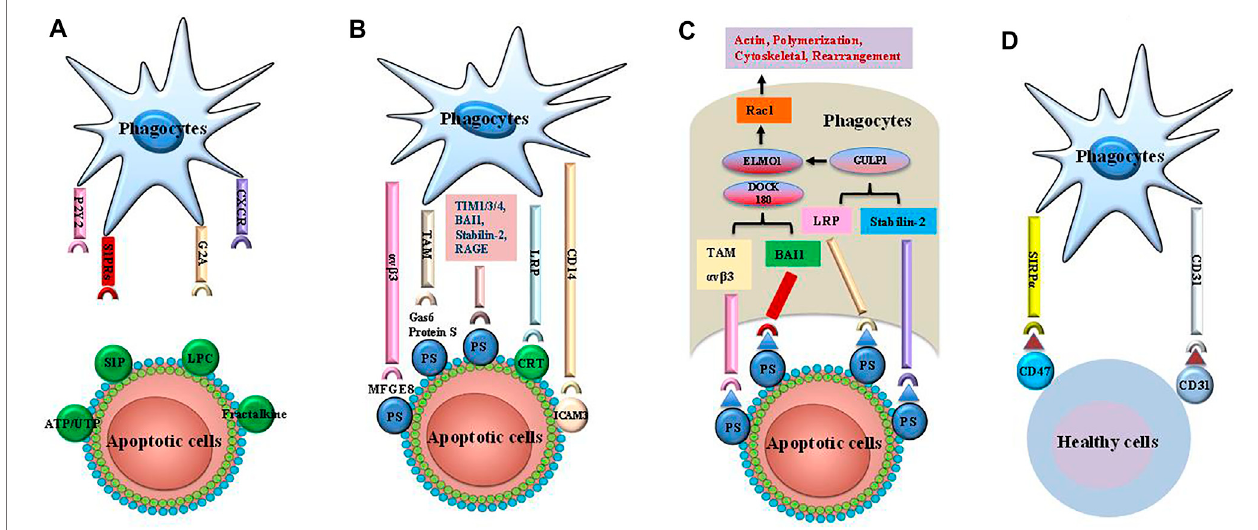
FIGURE1| Thestepsofefferocytosis.Efferocytosisisamulti-stepsprocessthatinvolvesseveralsteps: fi ndingapoptoticcells,bindingapoptoticcells,internalizing and digestion of apoptotic cells. (A) The apoptotic cells release a series of “ fi nd me ” signals including lysophosphatidylcholine sphingosine-1-phosphate (S1P), uridine diphosphate (UTP) and adenosine triphosphate (ATP), which attract phagocytes to region of apoptotic corpses. These signals are recognized by phagocytes using cognate receptors such as CXCR3, G-protein-coupled receptor (G2A), purinergic receptors (P2Y2), andsphingosine-1-phosphate receptor (S1PRs). (B) The “ eat me ” signalsontheapoptoticcellsaresensedbyphagocytes,whichingestthesedyingcells via severalreceptorsandbridgingmolecules.Thesecrucialsignalscomprise brain-speci fi c angiogenesis inhibitor 1 (BAI1), T cell immunoglobulin mucin receptor (TIM) 1, TIM3, TIM4, the receptor for advanced glycationend products (RAGE), stabilin-2, phosphatidylserine (PS)-speci fi c bridging molecules, growth arrest speci fi c 6 (Gas6), milk fat globule epidermal growth factor VIII (MFG-E8), and protein S. In addition, calreticulin (CRT) and intercellular adhesion molecule (ICAM) 3 act as the “ eat me ” signals via interaction with CD14 and low-density lipoprotein-related protein (LRP). (C) Engulfment of apoptotic cells are conducted by phagocytes by recruitment of ingestion receptors along with Rac pathways, the polymerization of actin and rearranging of cytoskeletal. Ingestion receptors can recruit the DOCK180/ELMO1 set [ α v β 3, integrin, Tyro3-Ax1-MER proto-oncogene tyrosine kinase (MERTK) (TAM), stabilin-2,and LRP]. D. Healthy cells canresistefferocytosis and leave phagocytes unengulfed via “ tolerate me ” signals(e.g.,CD47, CD31) on thecellsurface.SIRP α on the surface of phagocytes can recognize CD47. Similarly, CD31 homodimerizes with CD31 on the phagocytes. Finally, mitochondrial fi ssion and an increase in cytoplasmiccalciumoccursinefferocytes.Thesecellularchangesarecriticalforphagosomesealing.Phagosomefusionwithlysosomeleadstodegradationofapoptotic cells via acid hydrolase activity. The processing of engulfed apoptotic corpses uses microtubule-associated protein light chain 3 (LC3)-dependent phagocytosis and exhibit anti-in fl ammatory activities.